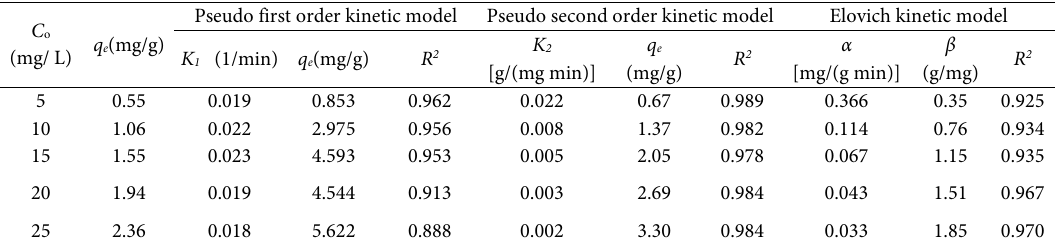
Table 2. Kinetic parameters for the adsorption of Cu (II) on Pseudo first order kinetic model Pseudo second order kinetic model Elovich kinetic model C o q e (mg/g) (mg/ L)